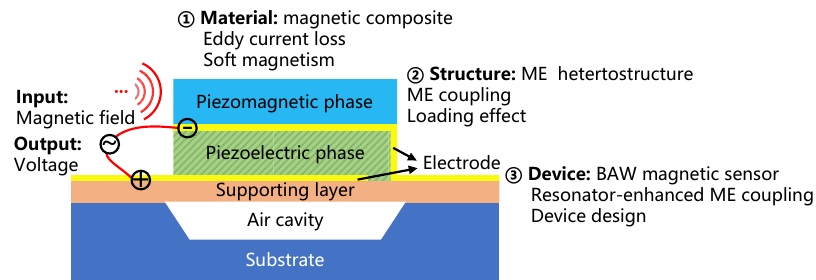
Figure 1. Mechanism of the BAW ME magnetic sensor and the optimizing method of the sensor’s performance by fine-tuning the design of the material, structure, and device to improve the energy coupling efficiency and decrease the energy loss.